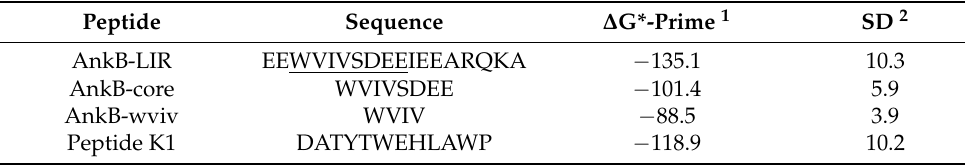
Table 1. Sequence and calculated ∆ G* values of AnkB analogs and K1 peptide. Peptide Sequence ∆ G*-Prime 1 SD 2 AnkB-LIR